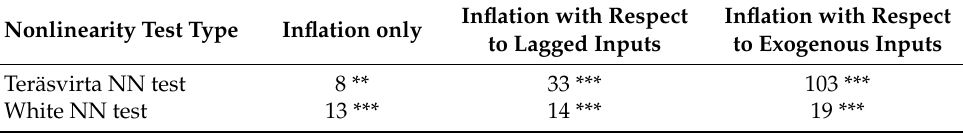
Table 3. Neural network tests for